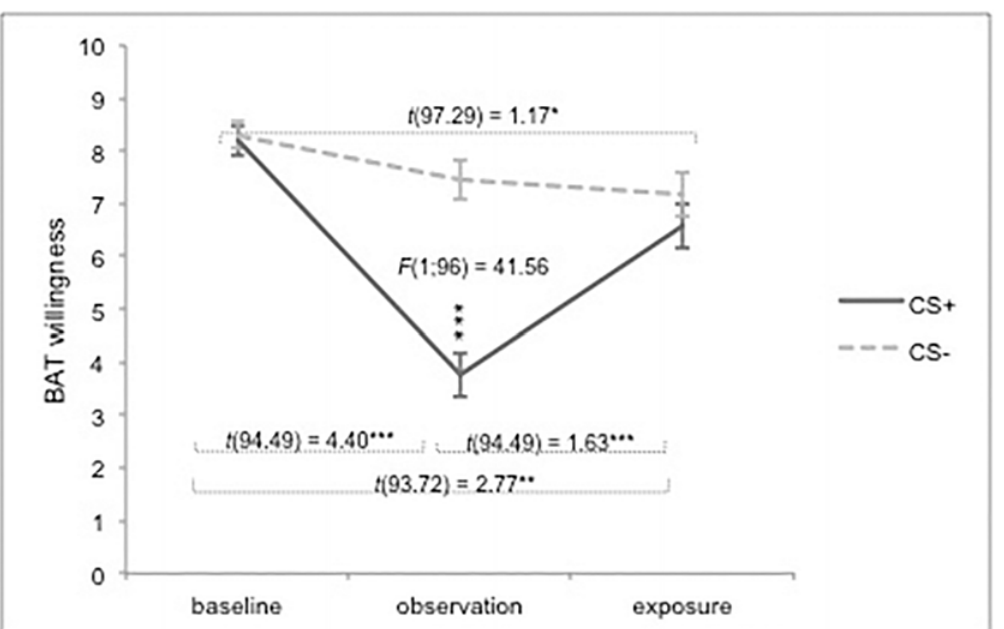
Fig 3. Self-reported behavioural avoidance tendencies in Experiment 1. Willingness to touch the metal bars. Error bars represent standard errors. BAT = Behavioural Avoidance Tendencies; * p < .05; ** p < .01; *** p <